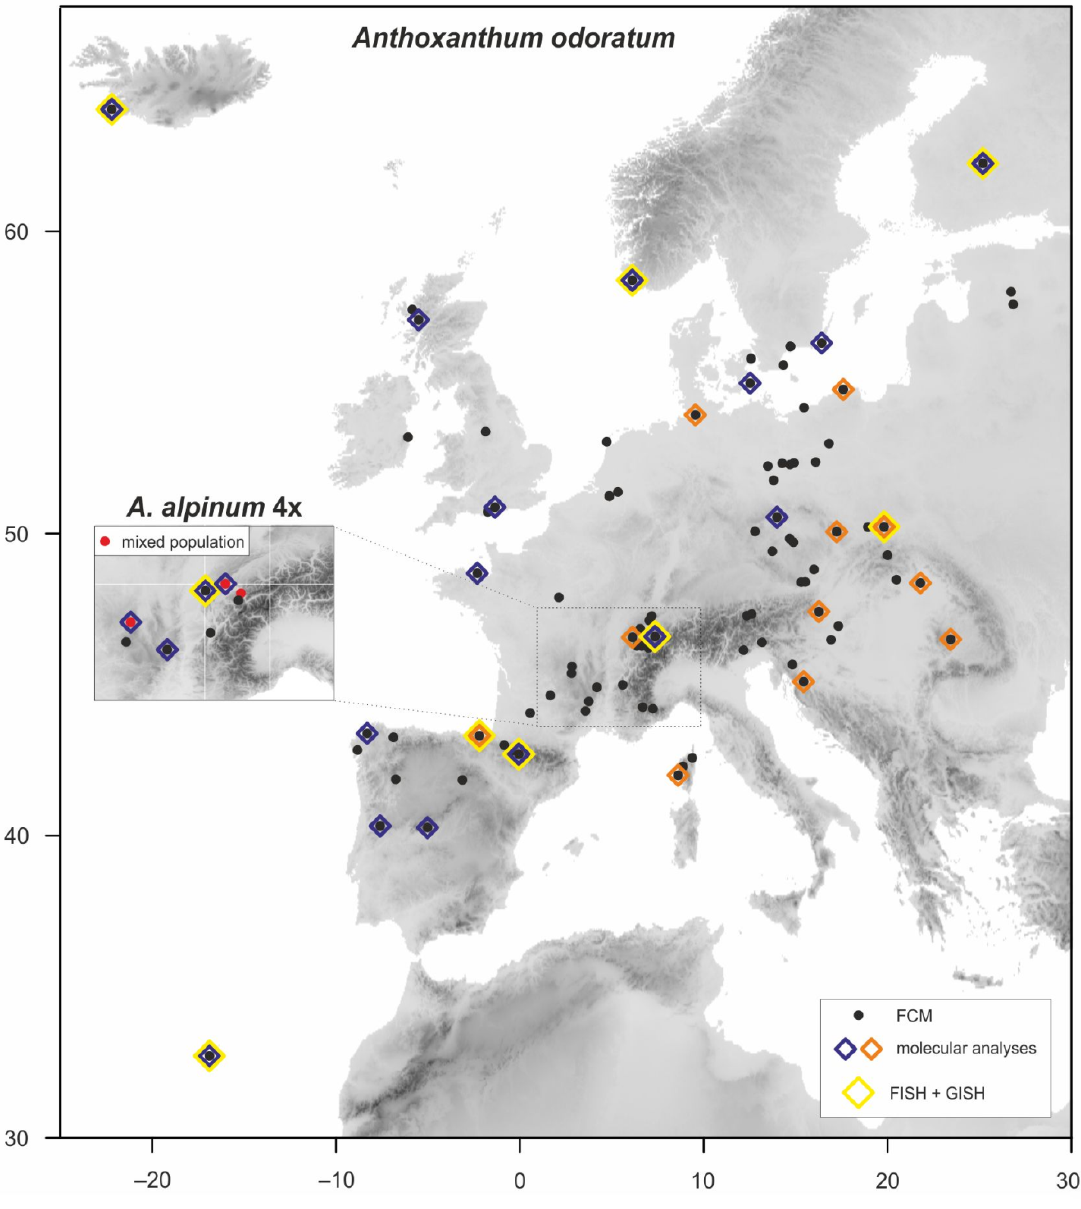
Figure 1. Map showing the locations of 103 populations of Anthoxanthum odoratum and 8 populations of tetraploid A. alpinum (in the inset cutout) included in the study. A supplementary color legend highlights the use of selected individuals in various analyses.